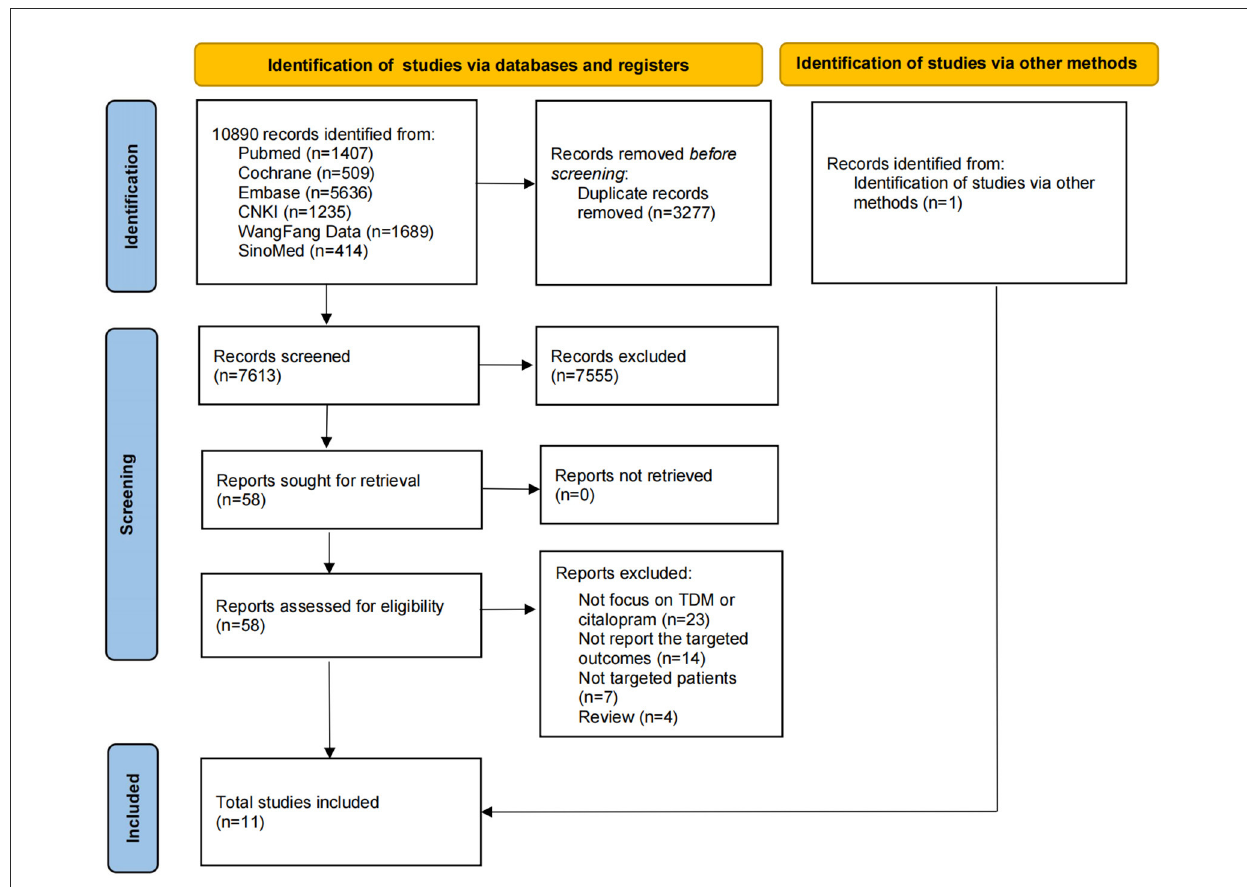
FIGURE1 The PRISMA 2020 flow diagram of study selection for the systematic